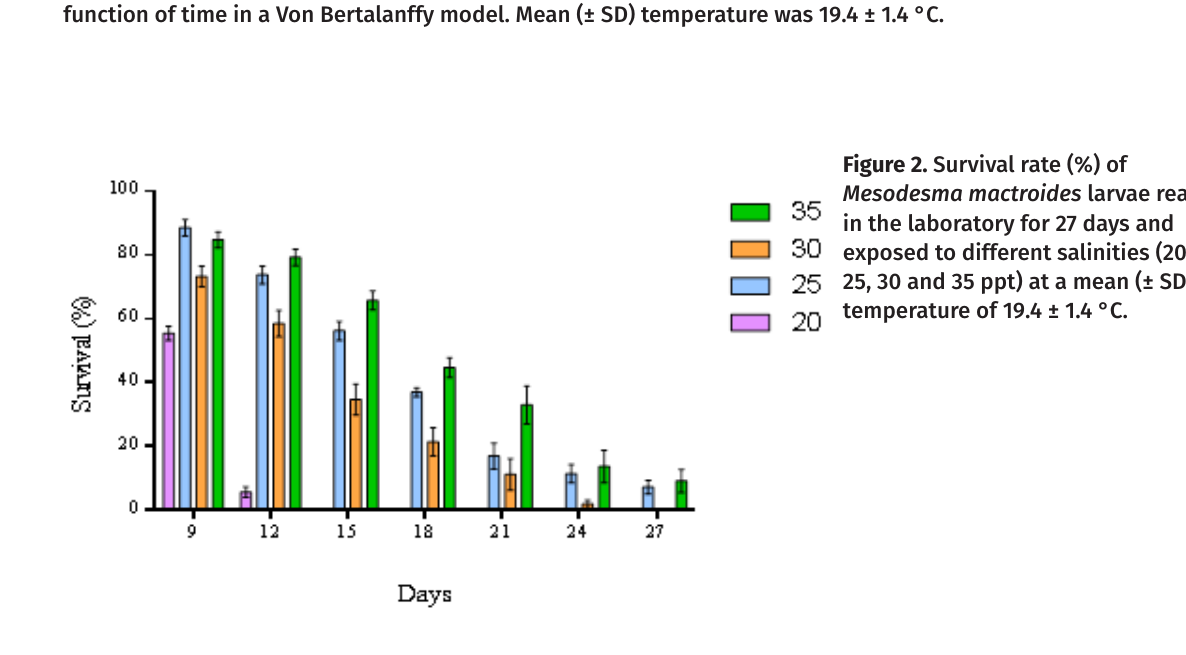
Figure 1. (a-c) - Mean height (a) and length (b) mean of Mesodesma mactroides larvae exposed to different salinities: 20, 25, 30 and 35 ppt in laboratory, with 27 days duration of culture. (c) Mean height of larvae as a function of time in a Von Bertalanffy model. Mean (± SD) temperature was 19.4 ± 1.4 °C.